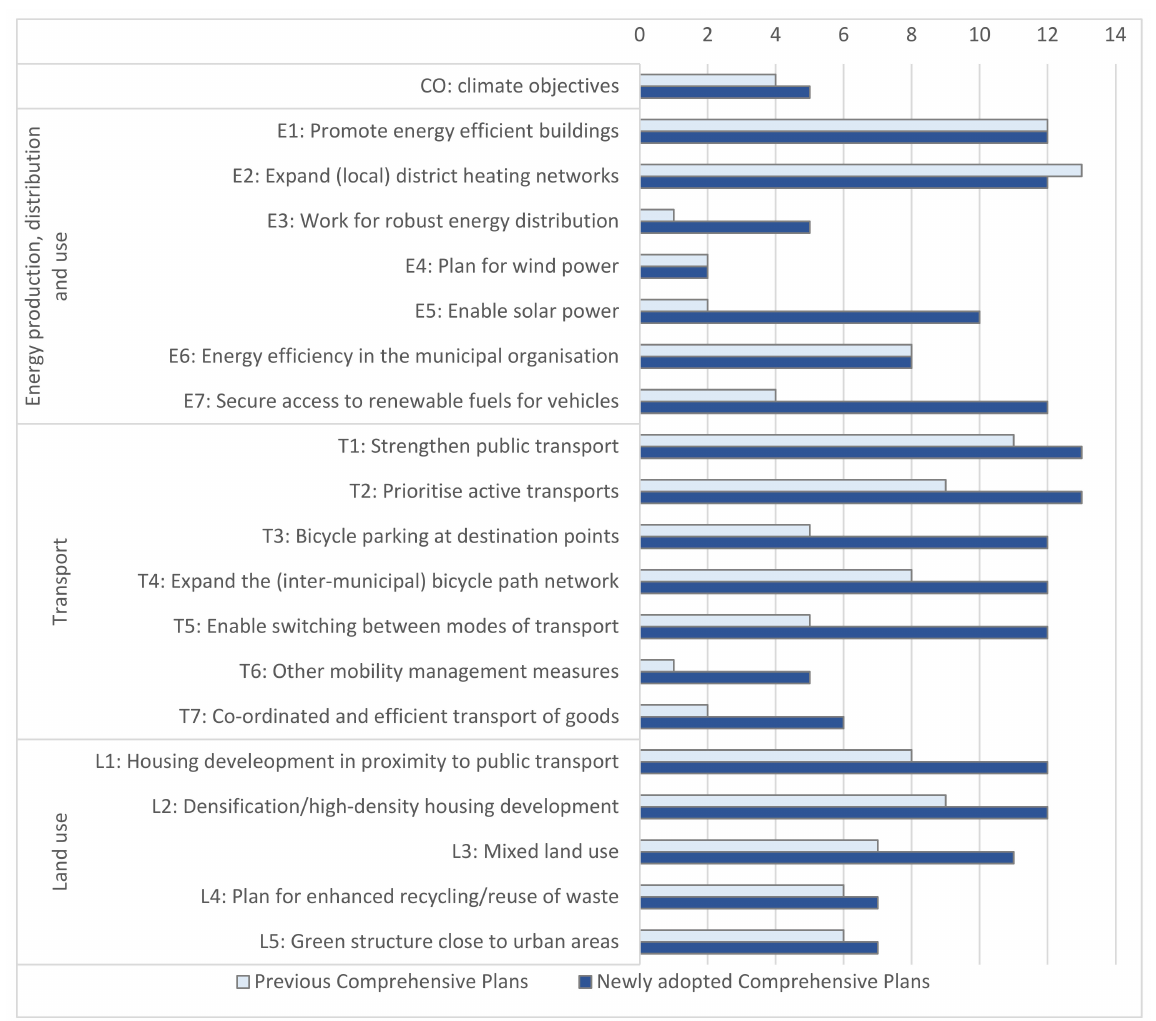
Figure 2. A comparison of the aggregated score for previously adopted Comprehensive Plans and recently adopted Comprehensive Plans for each identified